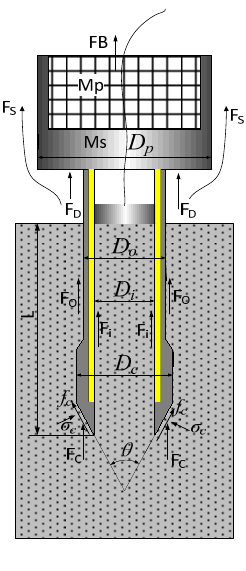
Figure 7. Diagram of all forces on the